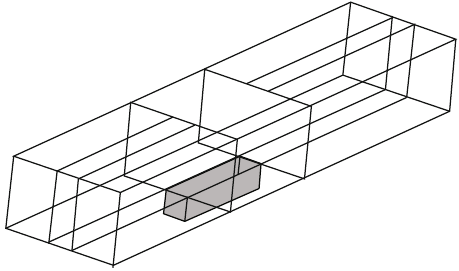
Figure 2: Computational domain of RANS.